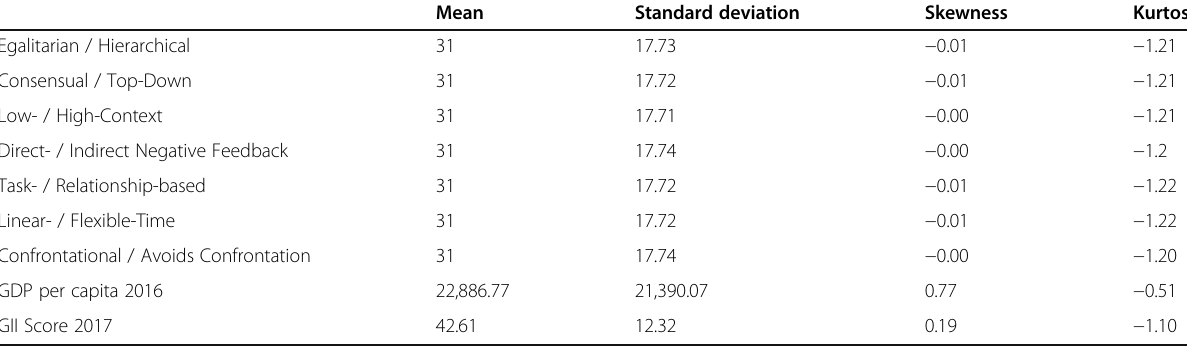
Table 4 Descriptive statistics – The Culture Map & GDP per capita 2016 & GII Score